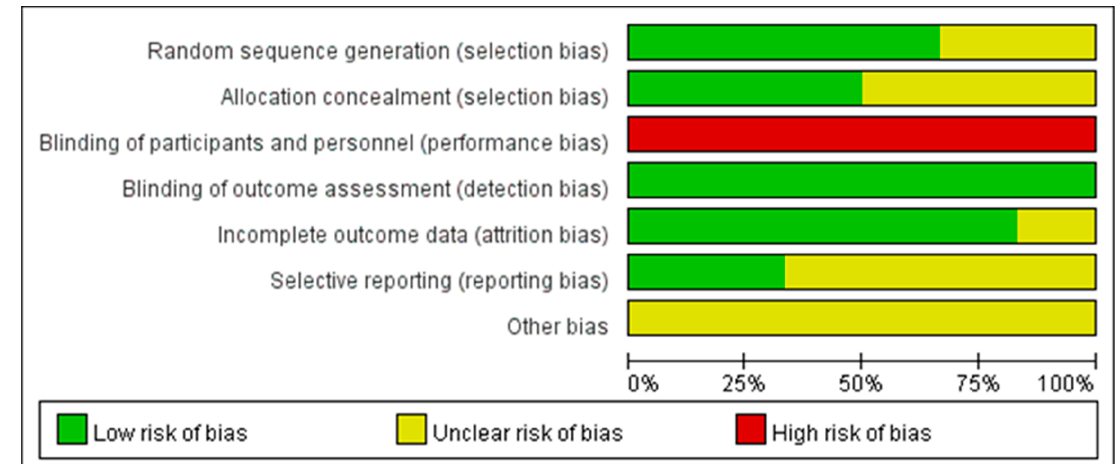
Figure A1. Risk of bias assessment.